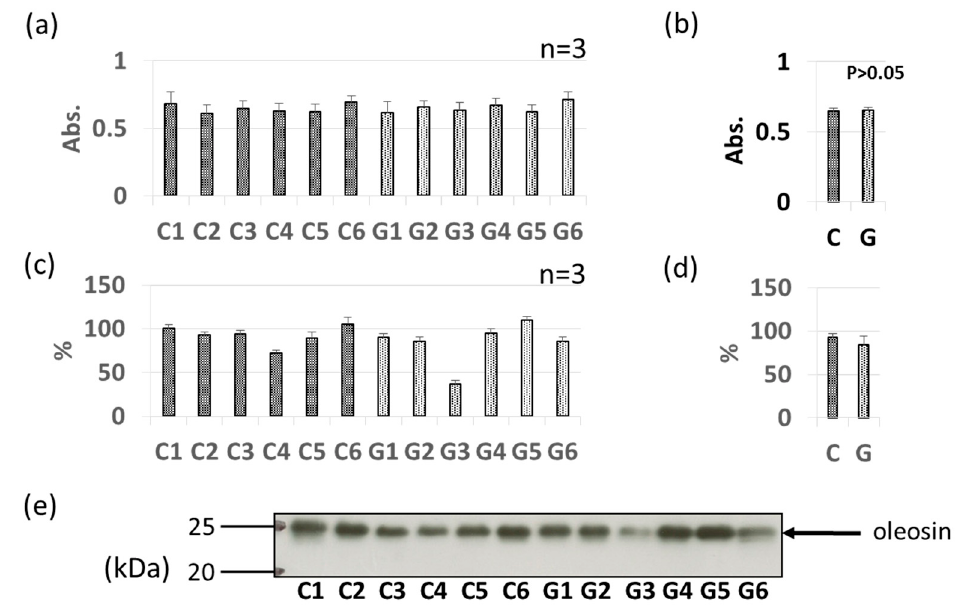
Figure 4. Comparison of oleosin levels in GM-and non-GM soybeans by ELISA ( a , b ) and immunoblotting ( c – e ) using rabbit-derived polyclonal antibodies. Soybean protein extracts were evaluated by ELISA ( a , b ) and immunoblotting ( c – e ) for detection of oleosin levels. The ELISA data are presented in absorbance values (Abs). The individual data from six GM-and non-GM soybeans ( a , c ) are presented as the mean ± SD of three independent replicates. The collated data ( b , d ) are presented as the mean ± SD of all individual data points from the control (C1–C6, six non-GM soybeans) or experimental (G1–G6, six GM soybeans) groups relative to the value of control number 1 (C1). A representative immunoblot is also provided ( e ) .